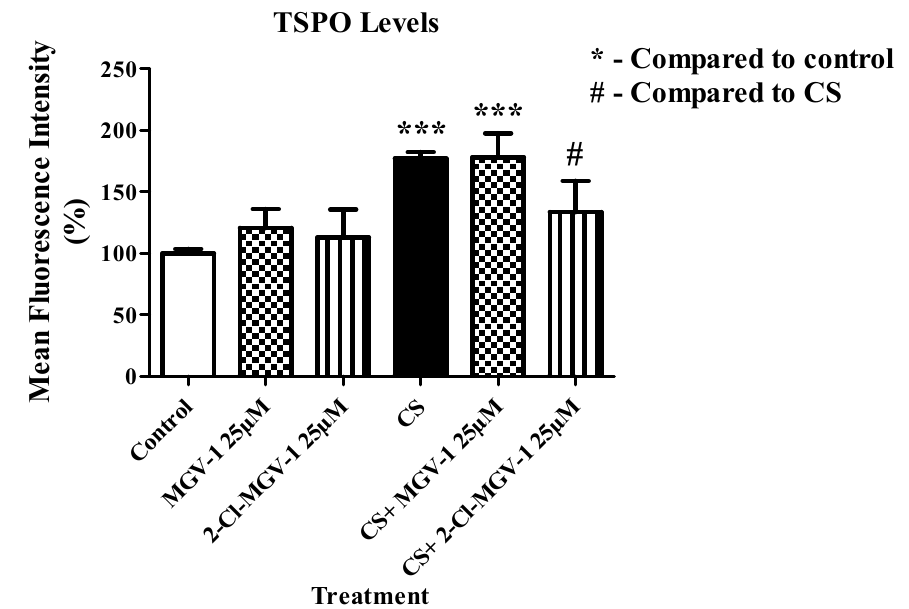
Figure 4. The impact of CS on TSPO levels in H1299 lung cancer cells. The alterations in TSPO levels measured by FACS. Elevation of TSPO expression levels due to CS exposure and the significant protective capacity of the TSPO ligand 2-Cl-MGV-1. Results are represented as mean ± SEM ( n = 4 in each group). # p < 0.05 vs. CS, *** p < 0.001 vs. control. CS = cigarette smoke.